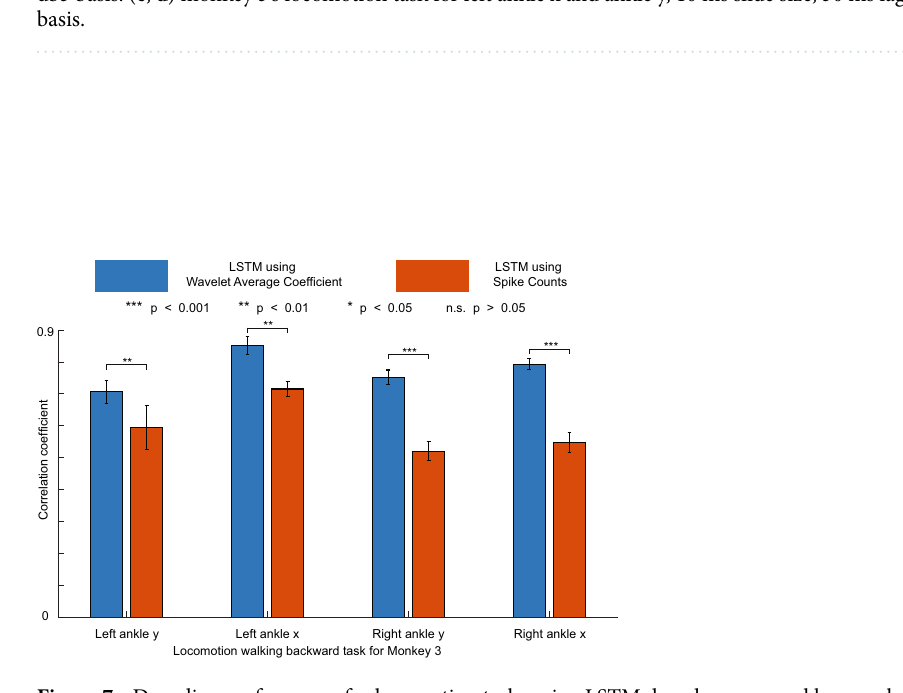
Figure 7. Decoding performance for locomotion tasks using LSTM decoder measured by correlation coefficient between decoded covariates and ground truths in 5-fold cross-validation (mean + / − S.D., n = 5 folds, 5ms temporal resolution). We use t-test on the z-score transformed from the correlation coefficient to validate the